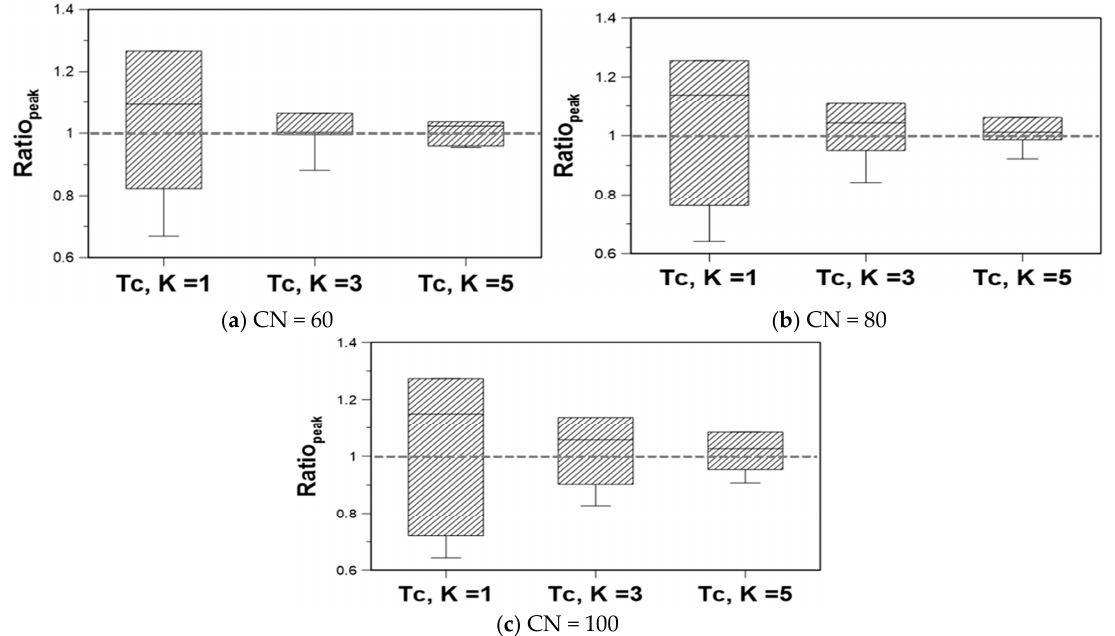
Figure 8. Comparison of the box-plots of the runoff peak flows derived with different CN and T c values.